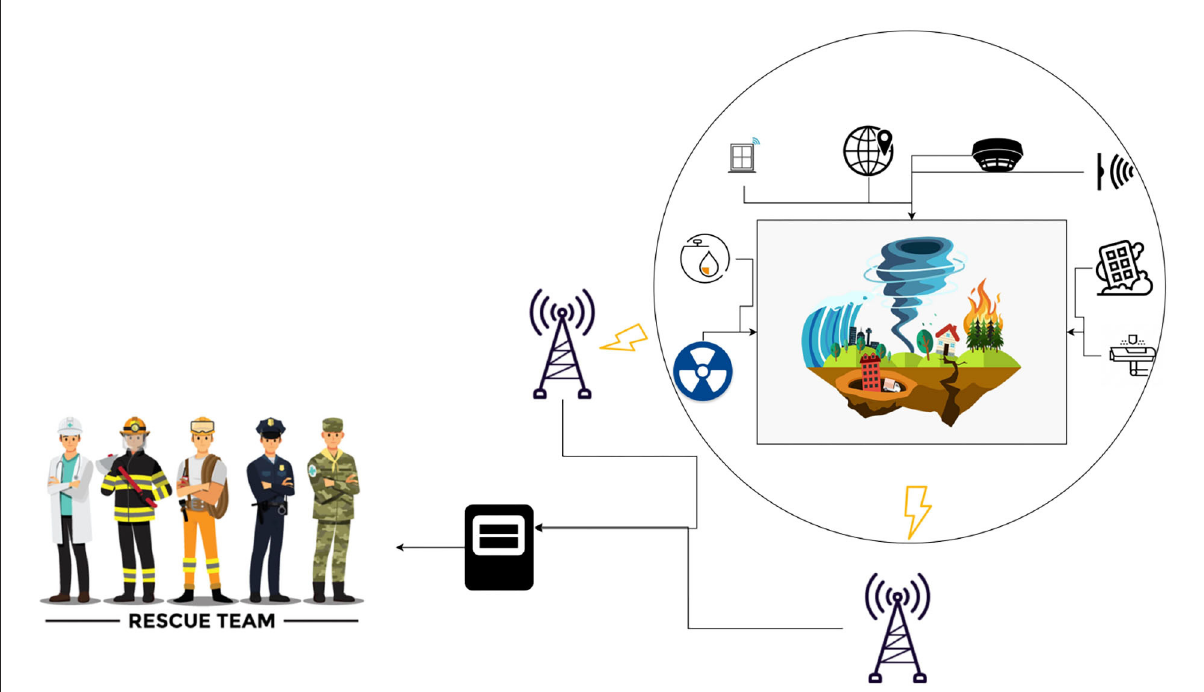
FIGURE1 The architecture of the